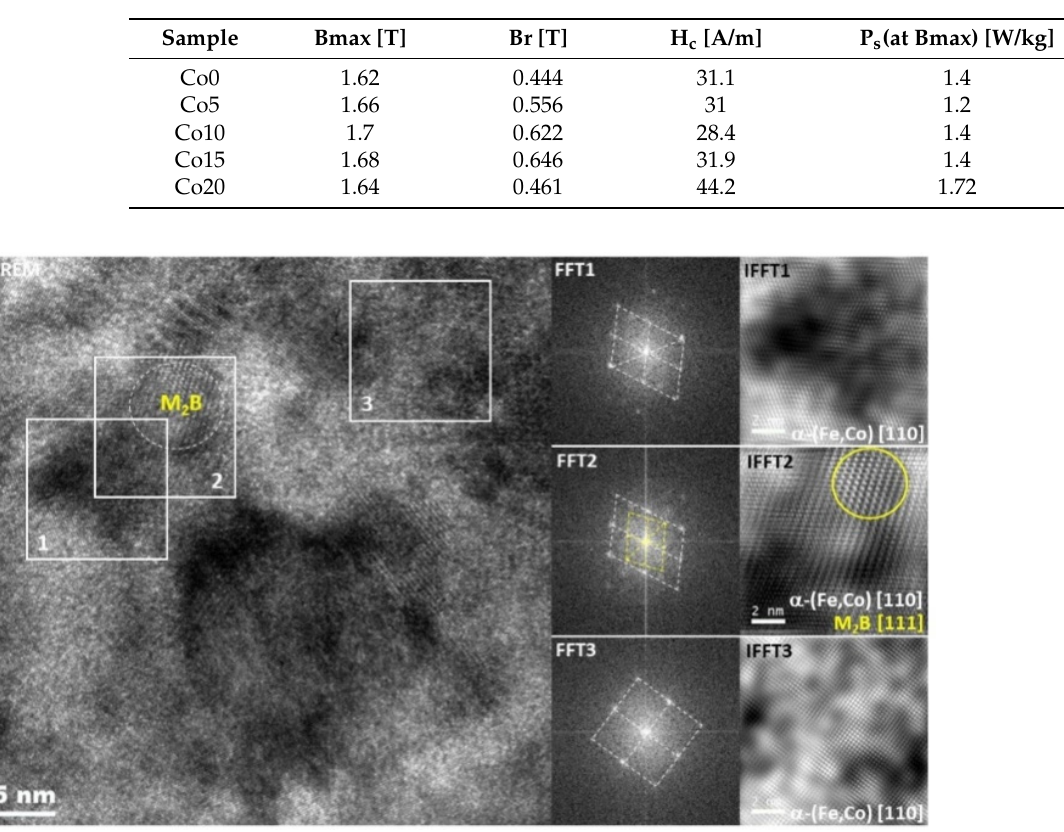
Figure 9. HREM image with corresponding FFT and IFFT taken from marked areas of the Fe 69.5 Co 5 Nb 5 B 8.5 P 2 ribbon.